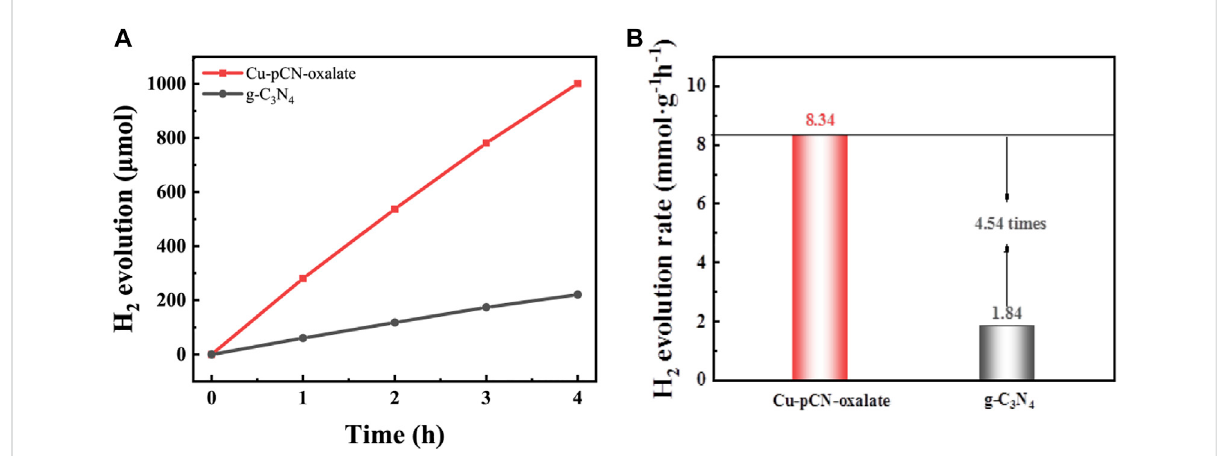
FIGURE 8 (A) Photocatalytic H 2 production amount and (B) average H 2 evolution rate of raw g-C 3 N 4 and the optimal Cu-pCN-oxalate catalyst with ideal single-atom Cu and -COOH defects. The reactions were performed in 10 vol% TEOA solution under visible light irradiation ( λ ≥ 420 nm) (30 mg of the catalyst used in each